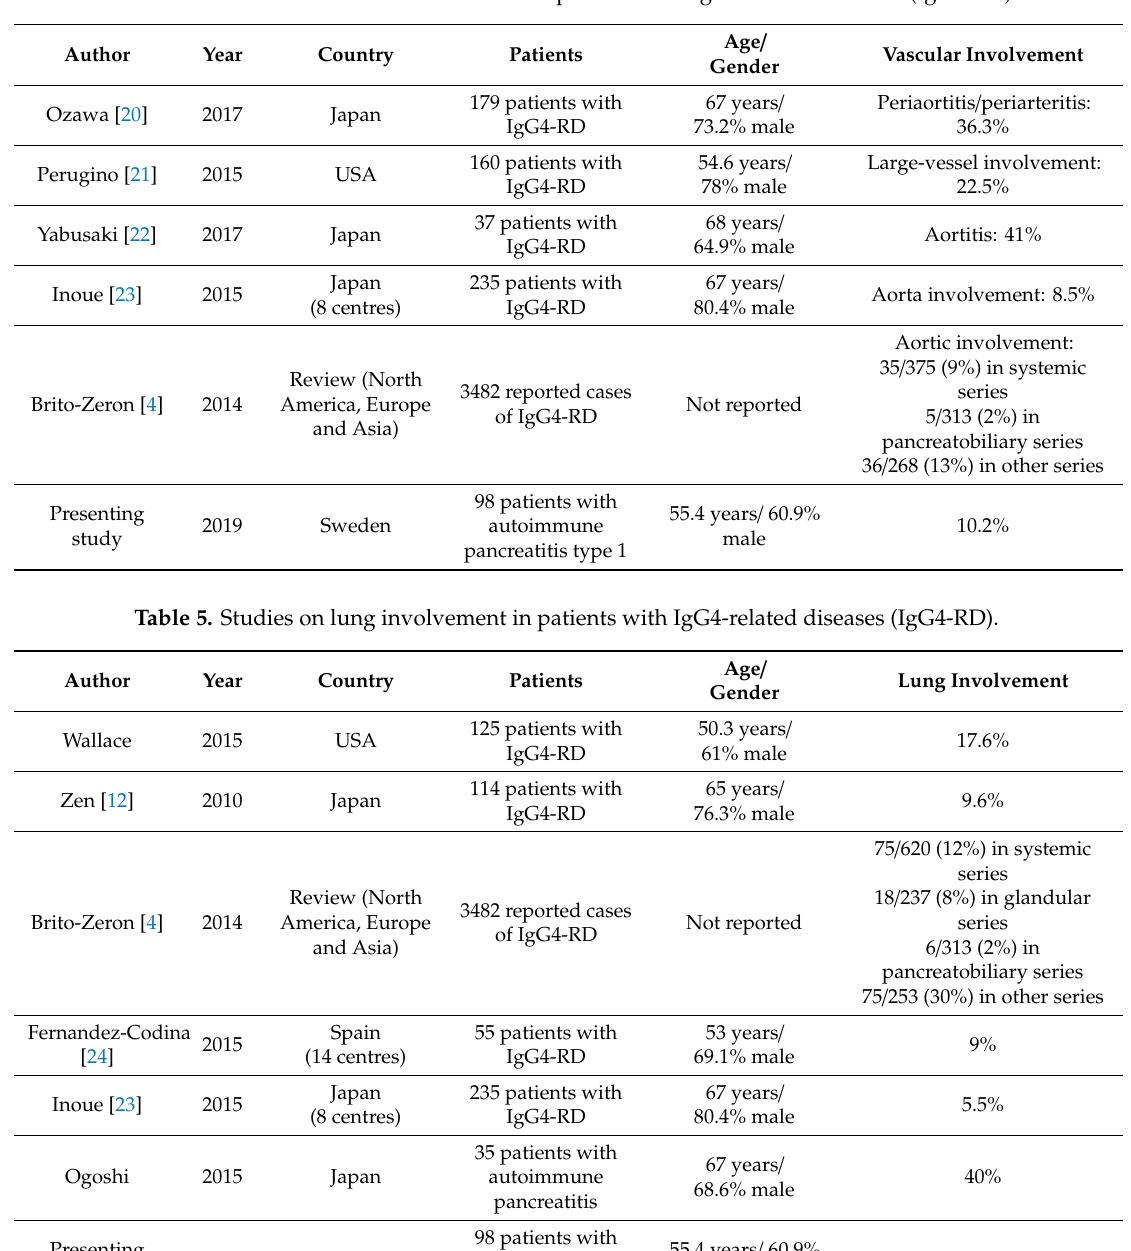
Table 4. Studies on vascular involvement in patients with IgG4-related diseases (IgG4-RD).